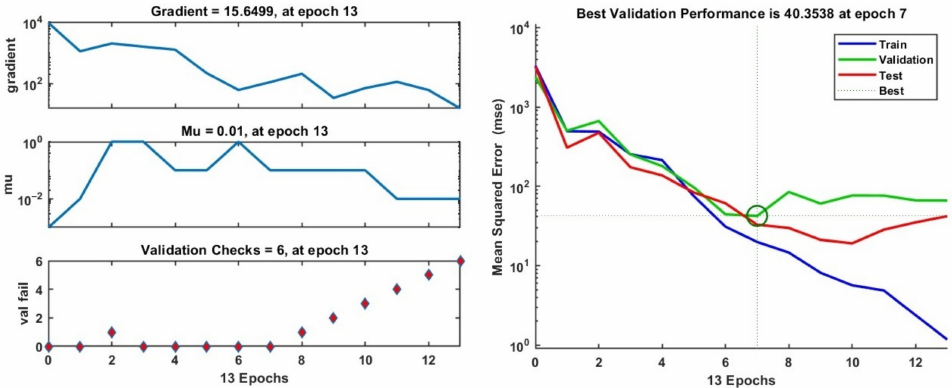
Figure 13. Training state and performance of the generated BPNN